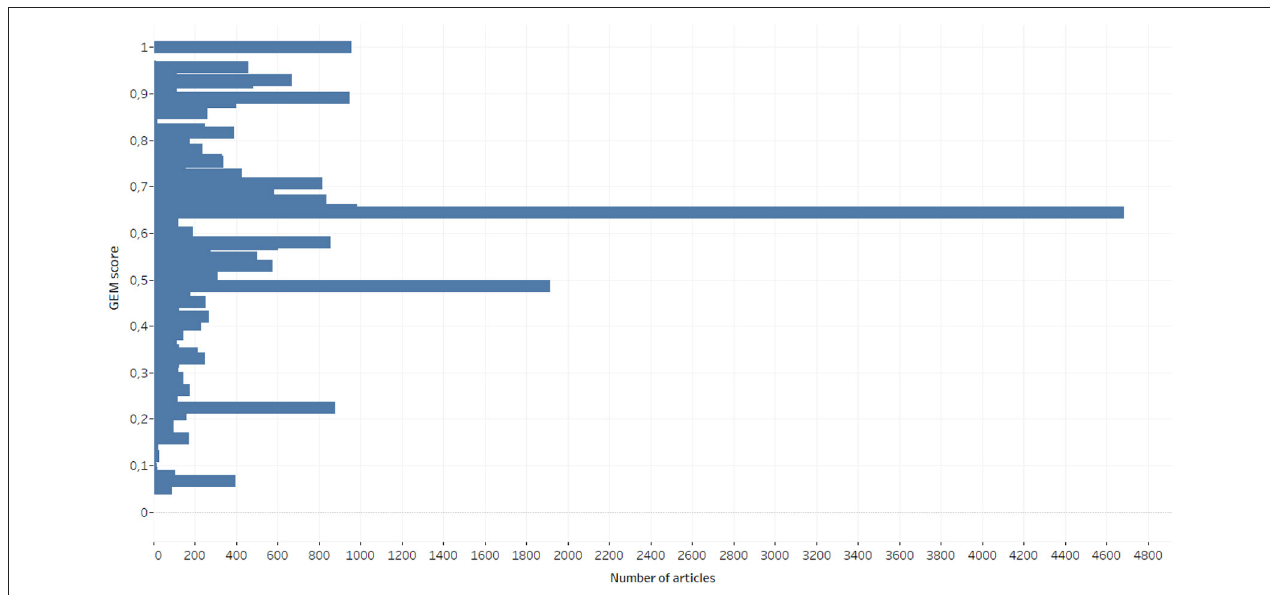
FIGURE 5 | GEM Score distribution for the whole dataset ( n =